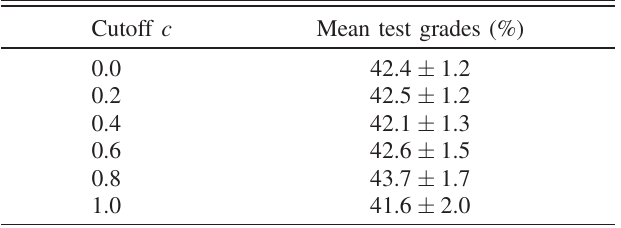
TABLE III. Mean test 1 grades for blue students for different cutoff